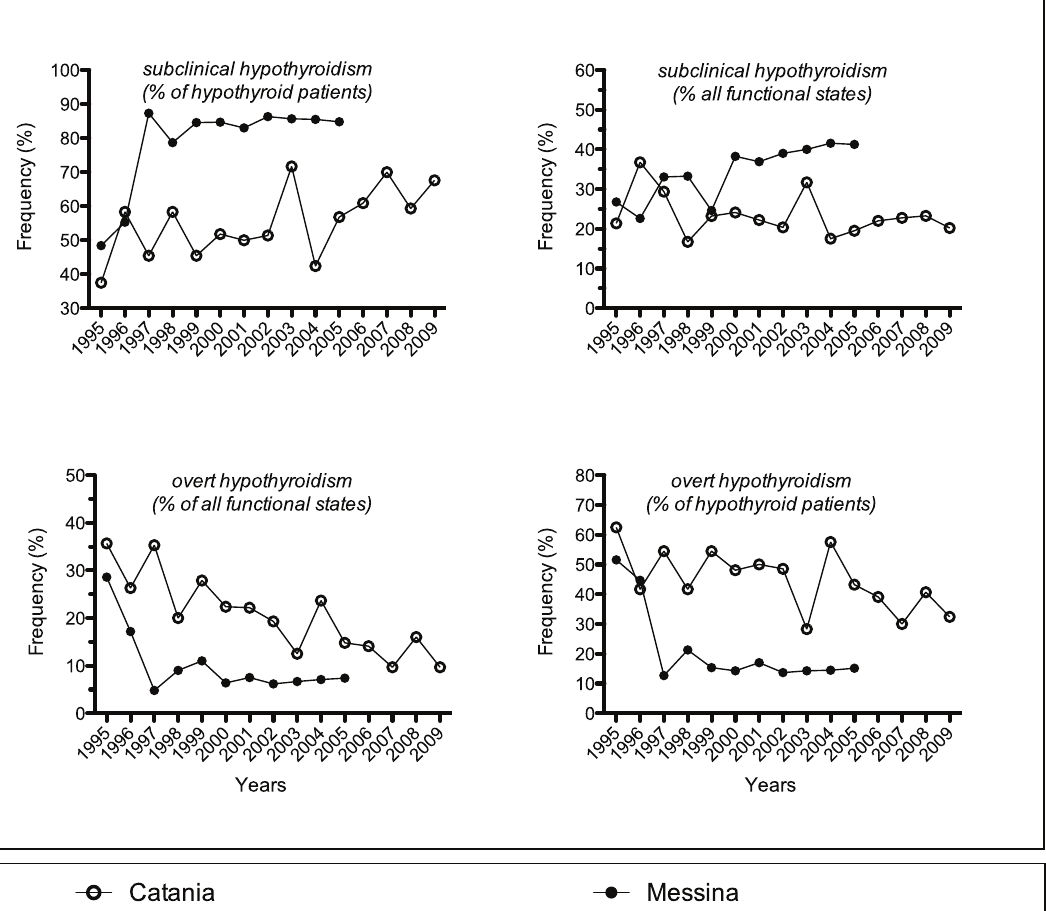
Figure 3. Yearly prevalence of the indicated functional states in the two Hashimoto’s thyroiditis cohorts of patients.